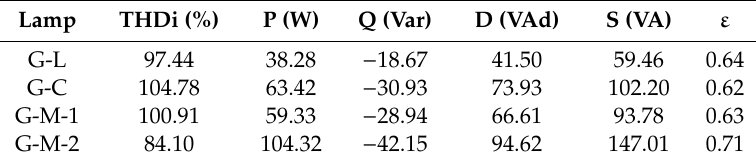
Table 8. Calculated values for the four